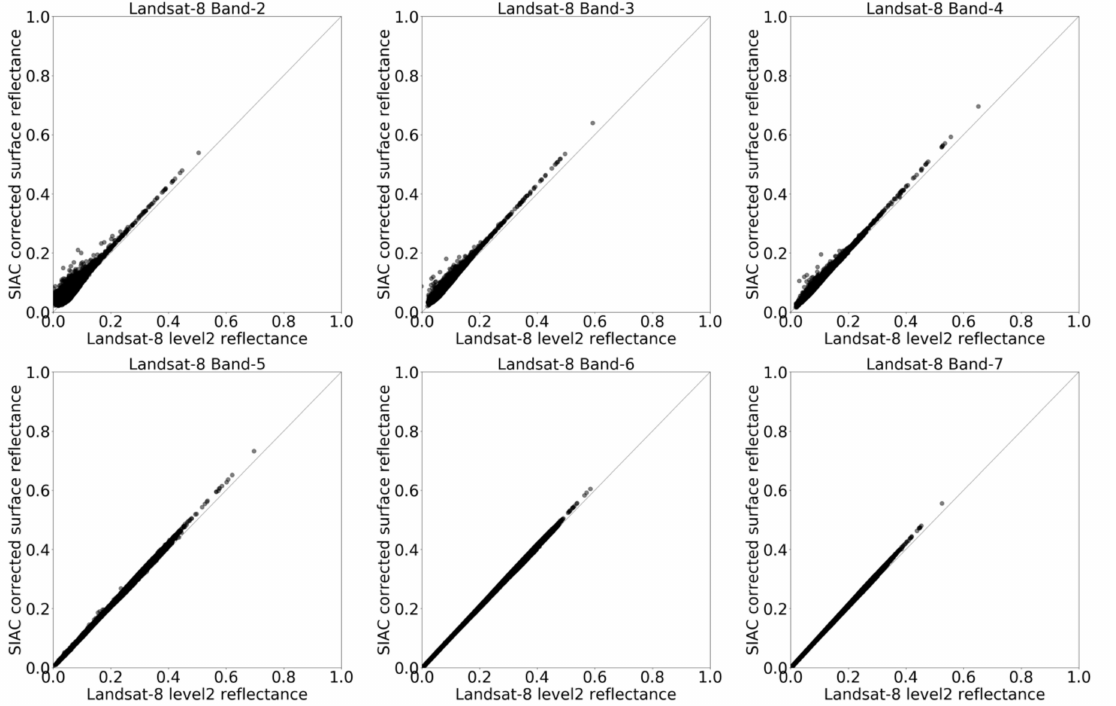
Figure 7. Intercomparison of Landsat-8 spectral surface reflectance derived from Landsat 8 Surface Reflectance Code (LaSRC) algorithm and SIAC processing at band 2 (482 nm), band 3 (561 nm), band 4 (655 nm), band 5 (865 nm), band 6 (1609 nm) and band 7 (2200 nm). This example uses the Landsat-8 scene in a 10 km * 10 km region that centres at the US-SXF site on 15 th November